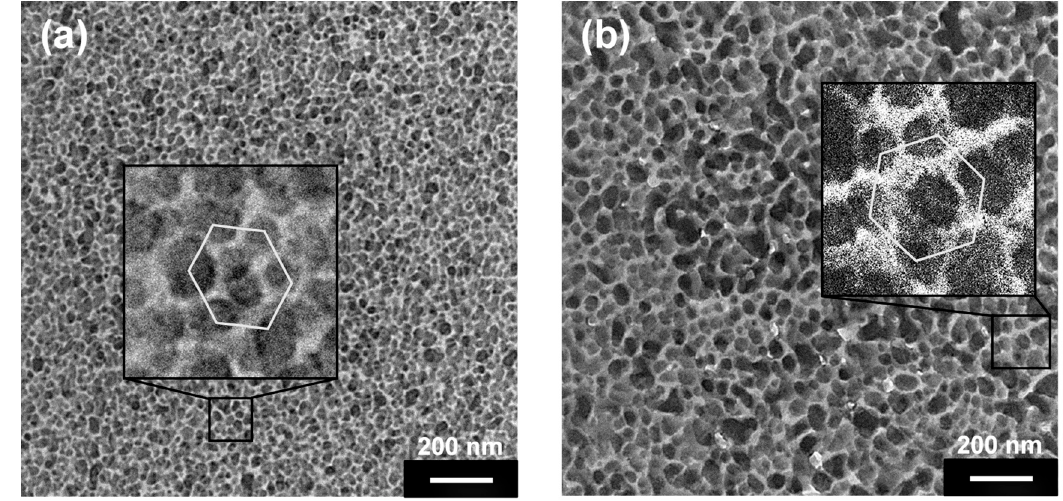
Figure 6. TEM images of films microtomed from small compact pellets thermally annealed at 150 °C for 24 h of block copolymers P 40 (7eAZO/eAZO)- b -PMMA 800 ( a ), and P 40 (10cCNB/eAZO)- b -PMMA 800 ( b ).